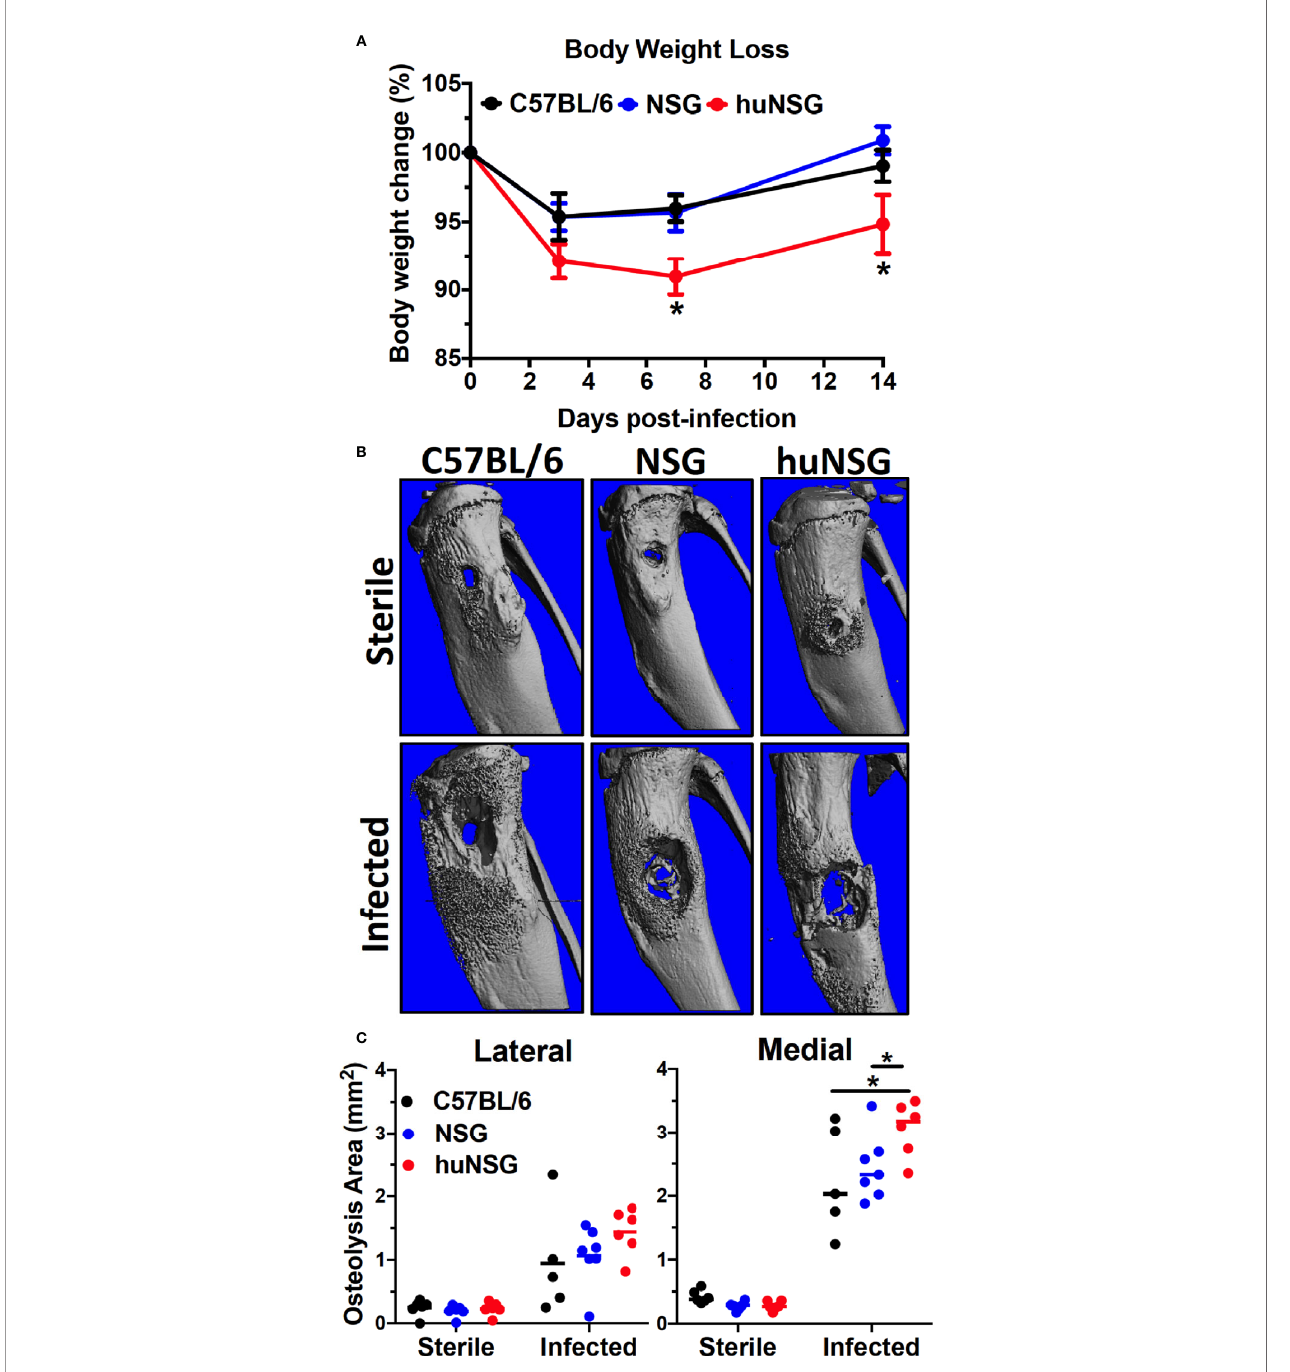
FIGURE 2 | Humanized mice exhibit increased body weight loss and osteolysis during S. aureus implant-associated osteomyelitis. (A) HuNSG mice and age- matched C57BL/6 WT, NSG controls underwent transtibial implantation of MRSA (USA300 LAC) contaminated stainless steel wire, and total body weight was assessed over the 2-week infection period. The % of baseline body weight on days 0, 3, 7 and 14 is presented for each group with the mean +/- SD (n = 14-17, * p < 0.05, two-way ANOVA). (B) Tibiae implanted with sterile and MRSA contaminated wires were harvested on day 14 post-op, processed for m CT, and representative 3D renderings are shown to illustrate the levels of reactive bone formation and osteolysis around the implants. Note the extensive osteolysis in the infected huNSG tibia. (C) The osteolysis area on the lateral and medial sides of the tibiae were quanti fi ed, and the data for each is presented with the mean +/- SD for the group (n = 6, * p < 0 .05, one-way ANOVA). Note that osteolysis is greater on the medial side in this model due to the directionality of wire implantation from the medial to the lateral